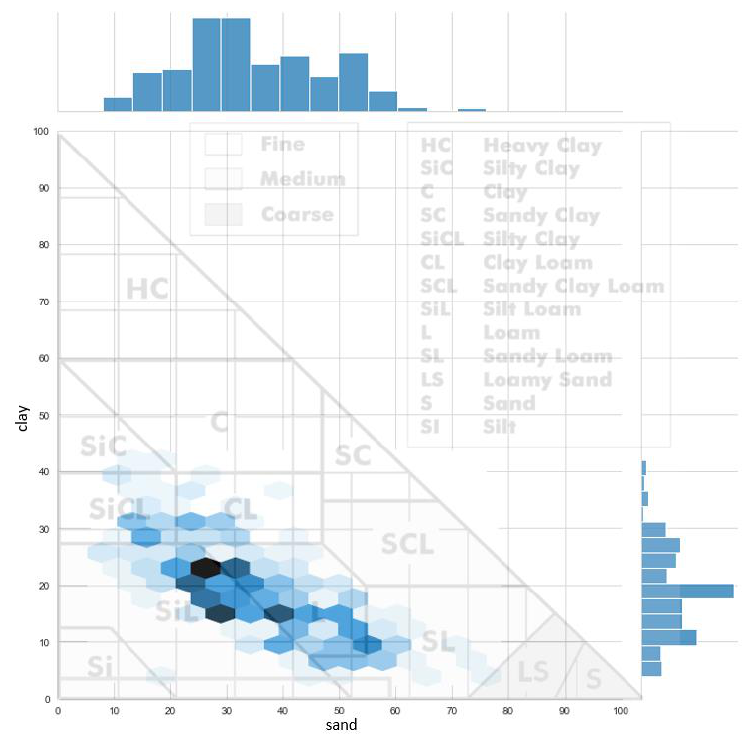
Figure 7 . Distribution of soil samples on texture triangle (Kastoria). Figure 7. Distribution of soil samples on texture triangle (Kastoria).